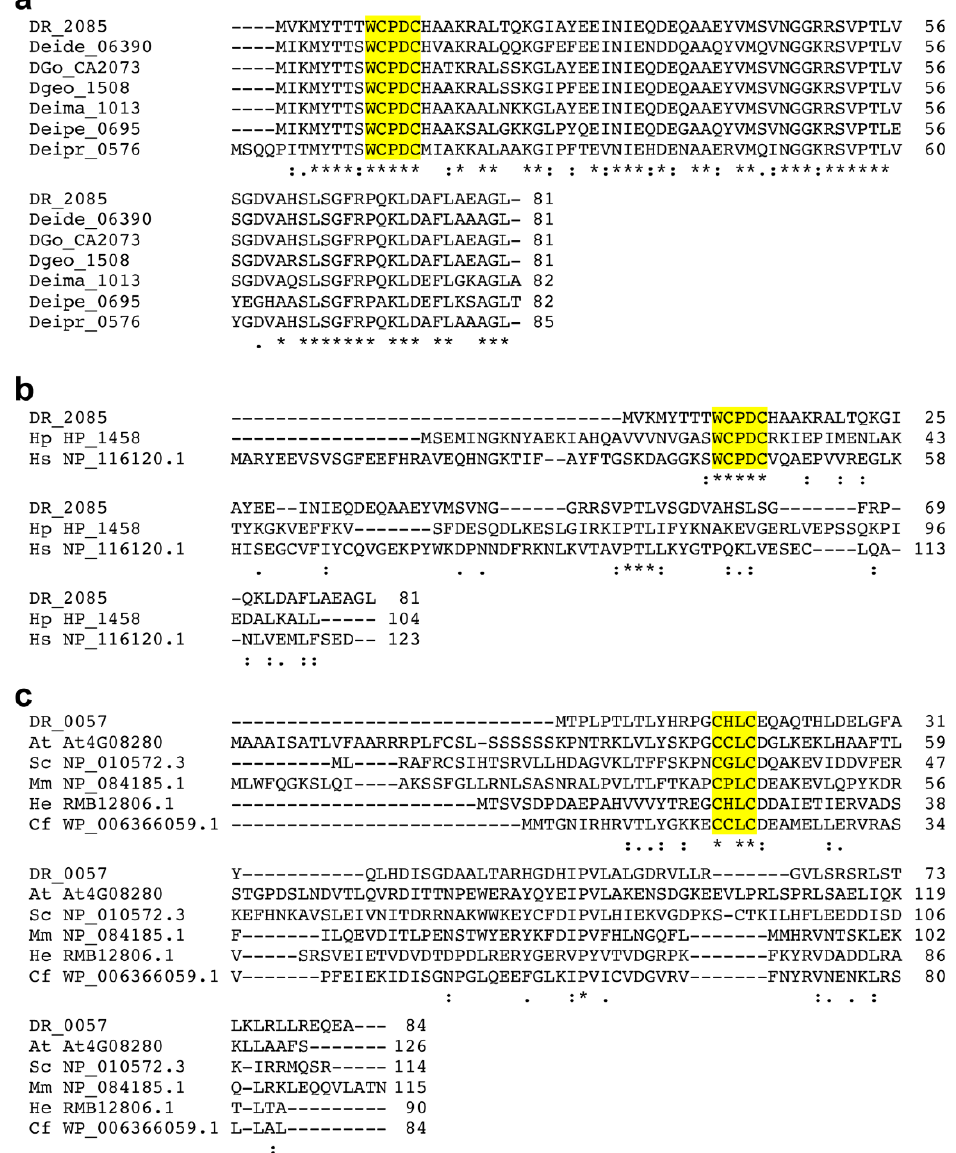
Figure 2. Multiple sequence alignments of TRX-like proteins from Deinococcus . ( a ) Alignment of Deinococcus DR_2085-type sequences. ( b ) Alignment of Deinococcus DR_2085 sequence with Homo sapiens (Hs) and Helicobacter pylori (Hp) homologous TRP14 Trxs. ( c ) Alignment of Deinococcus DR_0057 with Arabidopsis thaliana (At), Mus musculus (Mm), Saccharomyces cerevisiae (Sc), Haloplanus aerogenes (He) and Chlorobium ferrooxidans (Cf) homologous proteins. Trx active site sequences are highlighted in yellow. An asterisk (*) indicates positions which have a single, fully conserved residue; colon (:) and period (.) indicate conservation between groups of strongly and weakly similar properties, respectively. Abbreviations of Deinococcus species names are as specified in Table 1. Alignments were generated using UniProt ClustalO (https://www.uniprot.org/align/; accessed on 14 February